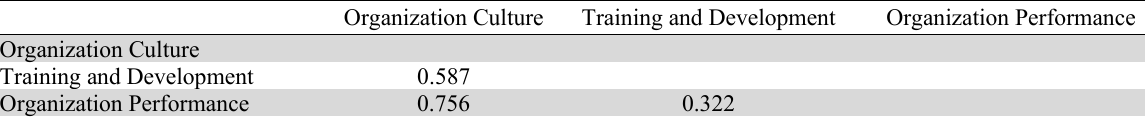
Heterotrait-Monotrait Ratio (HTMT)